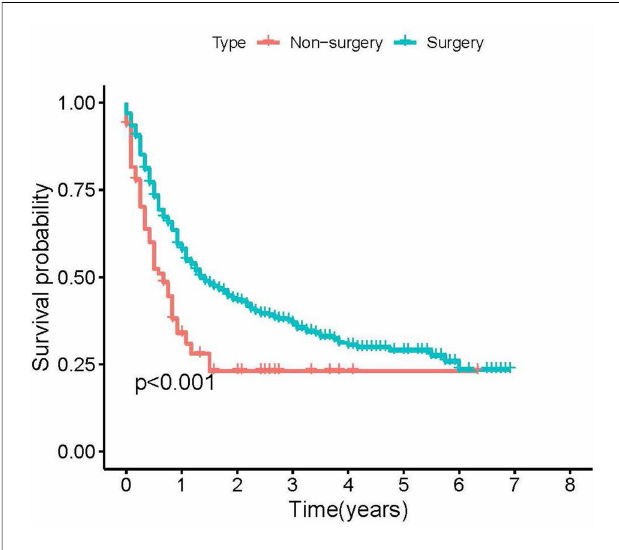
FIGURE 2 Kaplan-Meier plots of stage IV cutaneous melanoma patients according to primary site resection for cancer-speci fi c